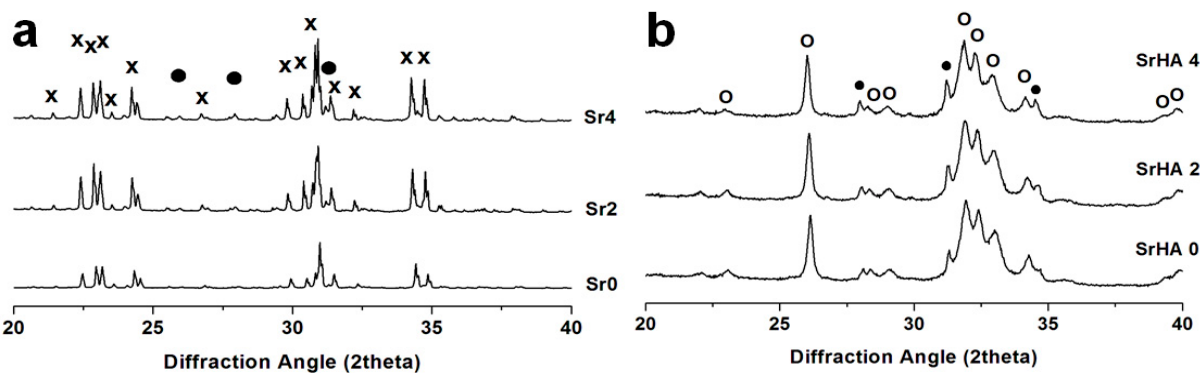
Figure 2. XRD patterns of Sr0, Sr2, and Sr4 powders prepared ( a ) and the correspondent Sr-containing apatite (SrHA) cements after 7 days of immersion in SBF at 37 °C ( b ). Peaks legend: α -TCP (X), β -TCP (•), CDHA (o).